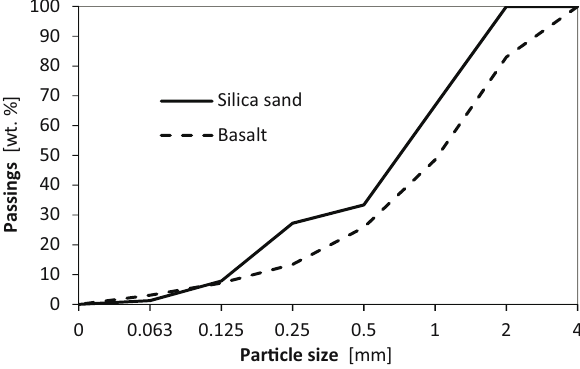
Figure 1: Particle size distribution of aggregates, obtained by sieving.